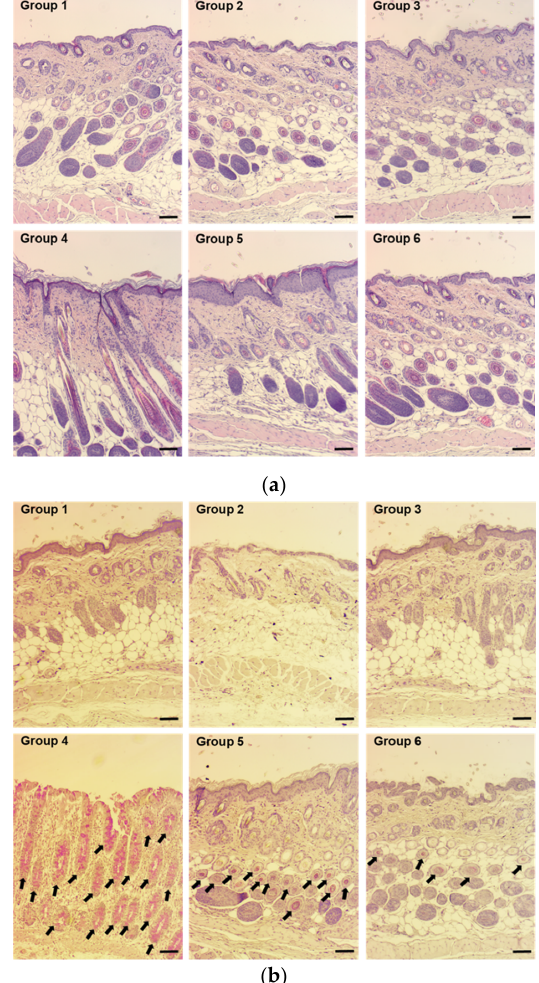
Figure 5. Representative light micrographs of tissue sections from normal, scratched, and scratched and fungal-infected mouse skin stained with ( a ) hematoxylin and eosin (H&E) and ( b ) periodic acid-Schiff (PAS) after 10 days of oral or topical ITZ treatment. PAS-positive reactions (red) were observed in the basement membrane of the epidermis, hair follicles, and sebaceous glands (black arrows). Scale bar = 100 µm.